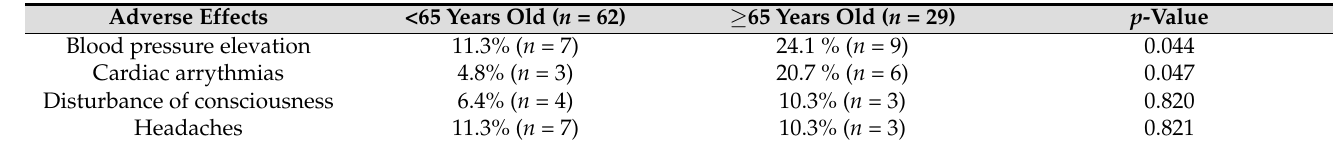
Table 3. Adverse effects of ECT by age